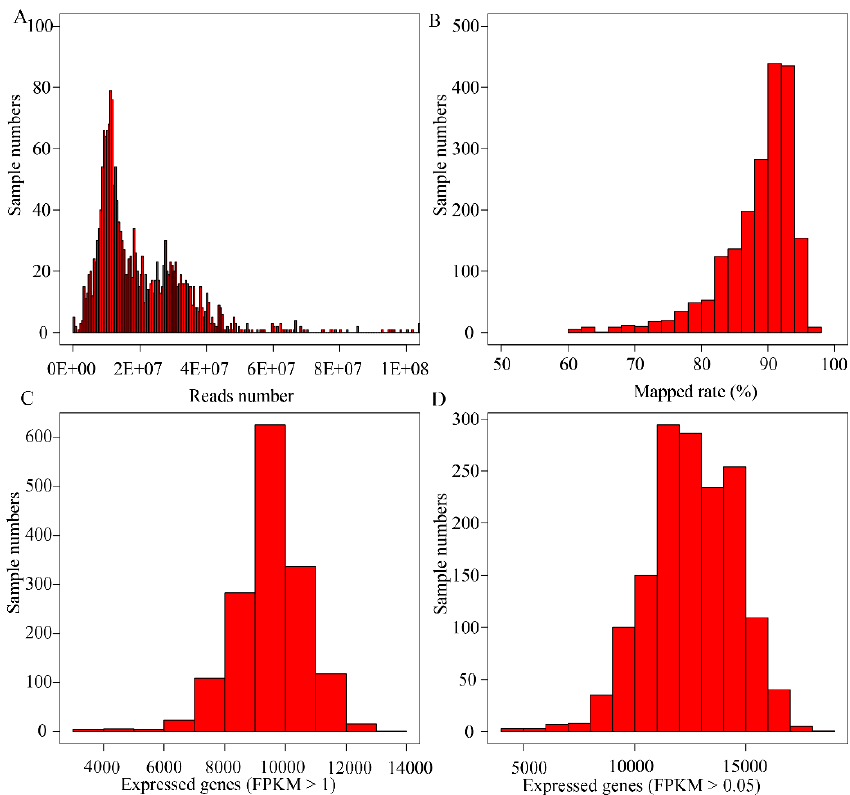
Figure 2. A landscape of the mapping data and expression. ( A ) Reads number distribution of all samples in Grape-RNA. ( B ) Mapping rate distribution of all samples in this database. ( C ) Gene number (FPKM > 1) distribution of all these samples. ( D ) Gene number (FPKM > 0.05) distribution of all these samples.